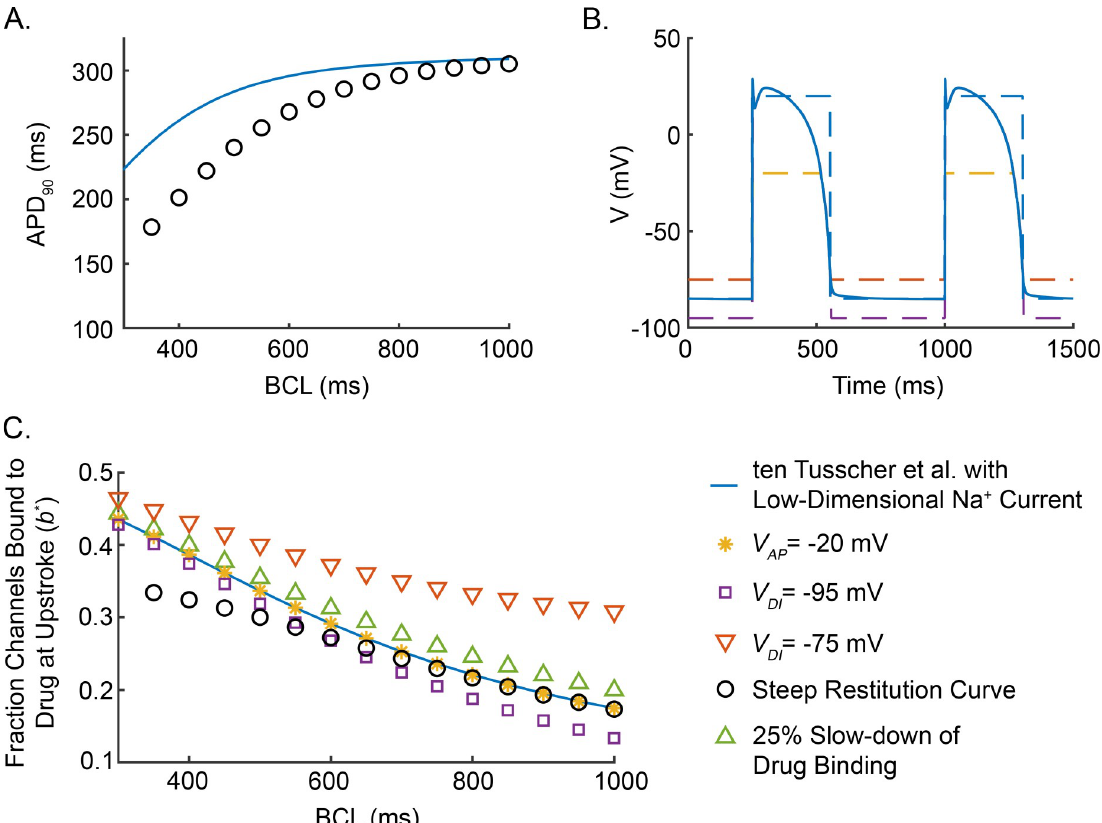
Fig 6. Cardiac electrophysiological properties and lidocaine binding. (A) APD 90 restitution curve for our modified ten Tusscher et al. model with 20 μM of lidocaine (blue curve) and a steeper, hypothetical restitution curve (black circles). (B) Time course of transmembrane potential for our modified ten Tusscher et al. model paced at a BCL of 750 ms and the square wave approximation of V (dashed blue line) as well as hypothetical alterations: V decreased to -20 mV (dashed yellow curve), V decreased to -95 mV (dashed purple curve), and AP DI V DI increased to -75 mV (dashed orange curve). (C) Fraction of channels bound to lidocaine during the upstroke ( b � (BCL) ) in the presence of 20 μM lidocaine, as given by Eq (5) , for our modified ten Tusscher et al. model and the various shifts in cardiac electrophysiological characteristics in (A) and